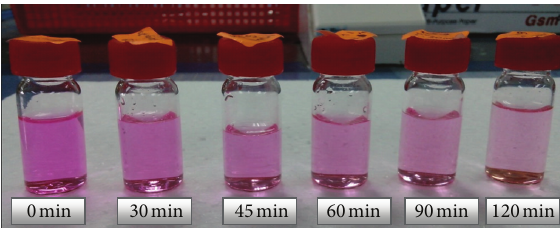
Figure 11: Degradation of RhB solution under UV light irradiation (254 nm) over a period of time by ZnO NRs.